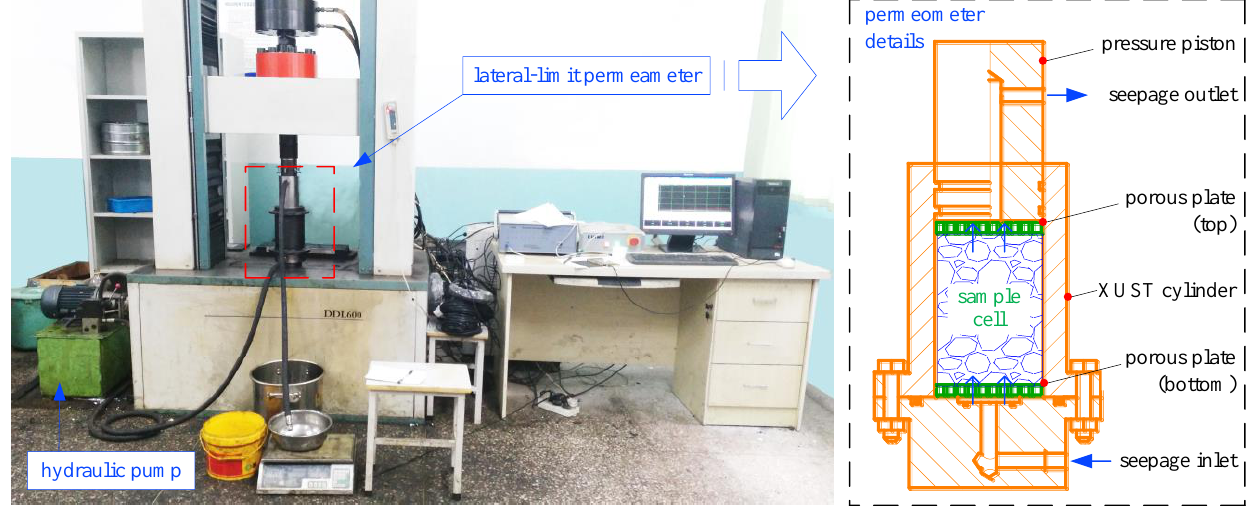
Figure 4. Diagram of the compression test equipment for breaking coal rock particles.